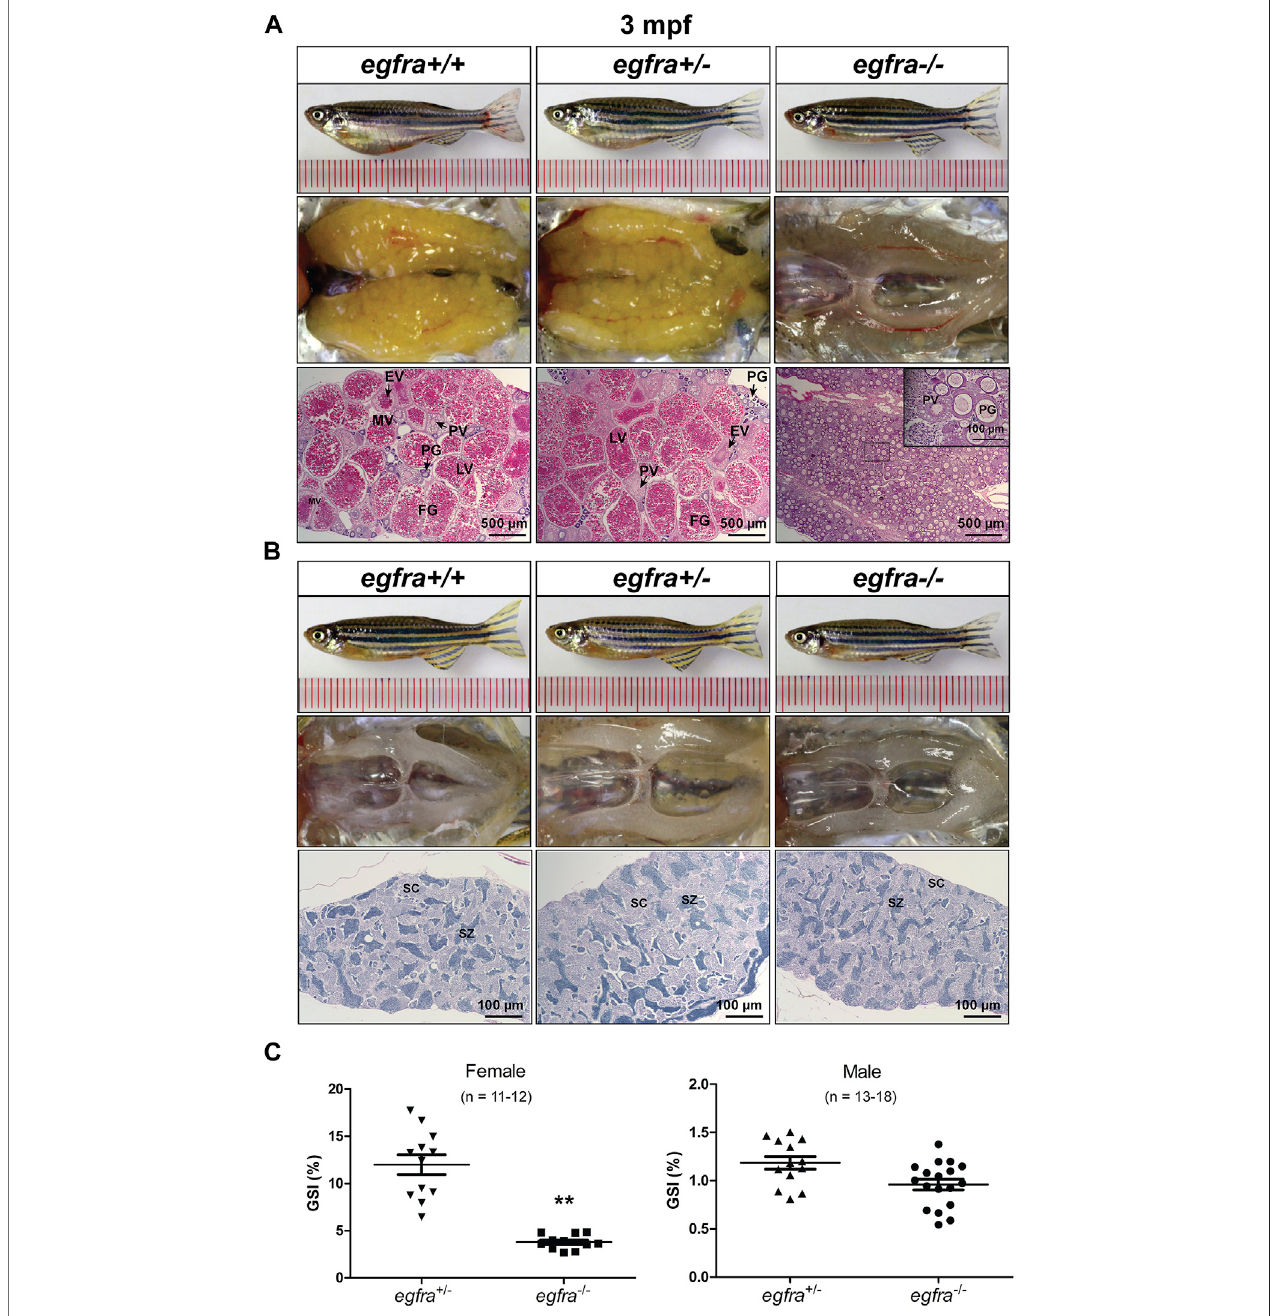
FIGURE 5 | Gonadal development of egfra mutant at 3 mpf. (A) Anatomical and histological examination of the ovary in egfra mutant ( egfra − / − ) and controls ( egfra +/+ and egfra +/ − ). The follicles of egfra -de fi cient females were arrested at PG stage with only a few entering early PV stage. (B) Anatomical and histological examination of the testis in egfra mutant ( egfra − / − ) and controls ( egfra +/+ and egfra +/ − ). The spermiogenesis was normal in egfra mutant males. (C) GSI of egfra - de fi cient females ( n (cid:1) 11 – 12) and males ( n (cid:1) 13 – 18). The GSI of female mutant was much lower than that of control whereas no difference was found in males (** p < 0.01). PG, primary growth; PV, previtellogenic; EV, early vitellogenic; MV, mid-vitellogenic; LV, late vitellogenic; FG, full-grown; SC, spermatocytes; SZ, spermatozoa.